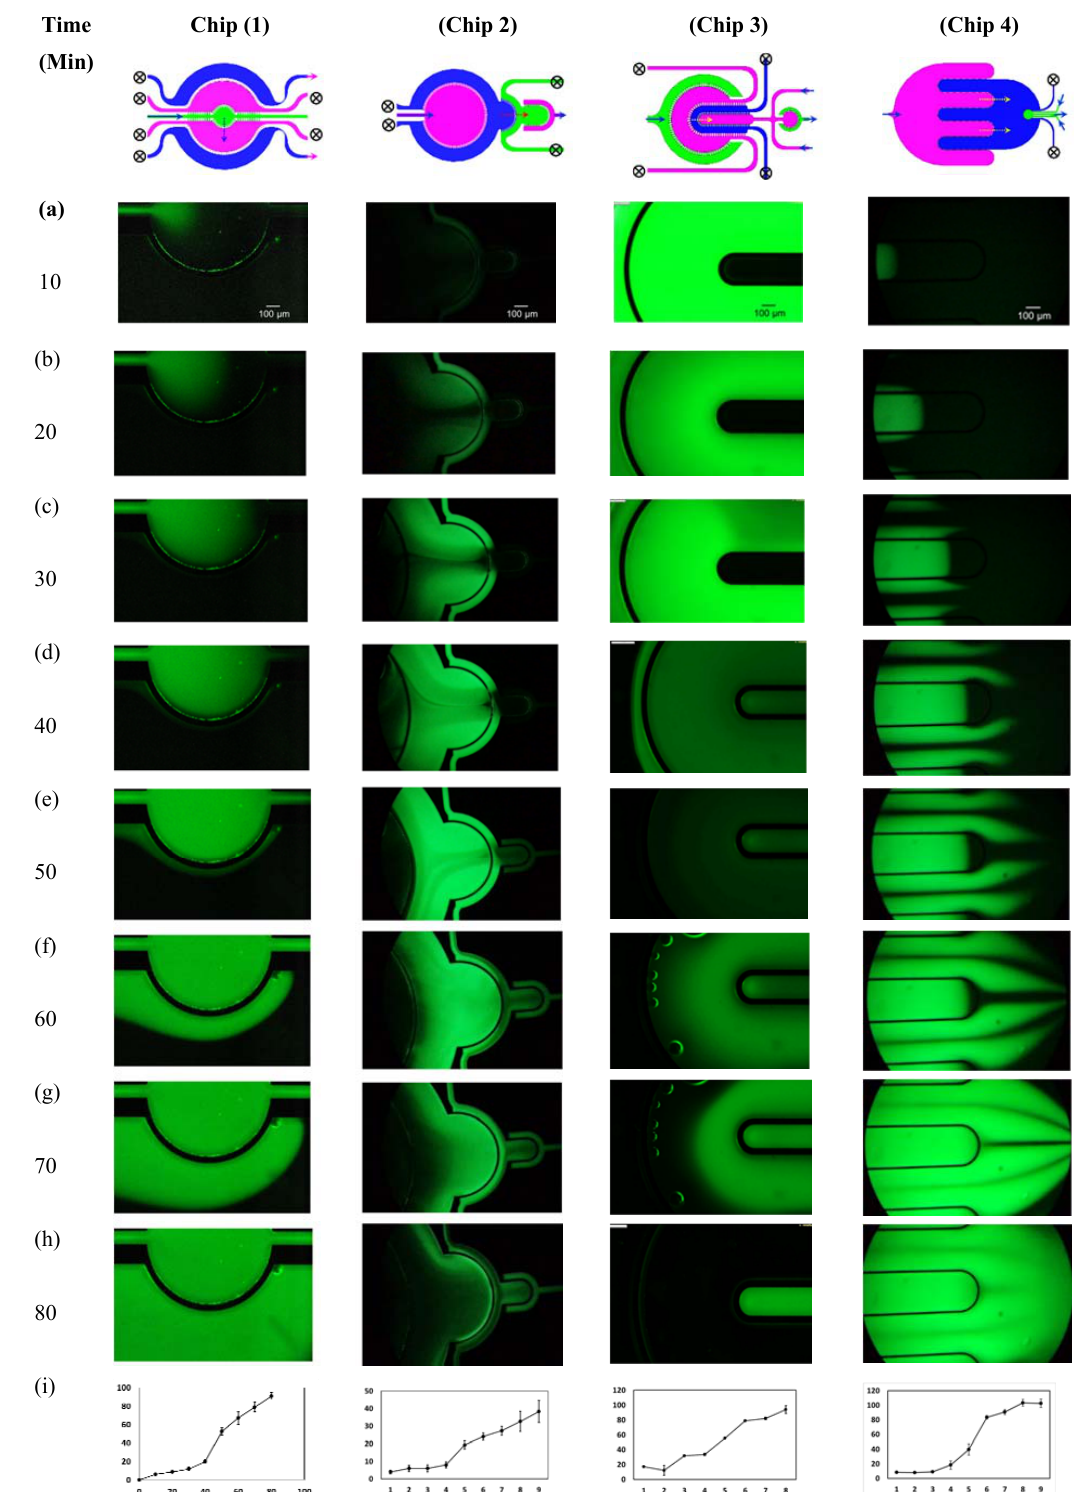
Figure 5. ( a – h ) Series of fluorescent images showing the inter-compartment transport of FITC-dextran at different time intervals over 90 min at a flow rate of 50 μ L/min. ( i ) Fluorescence intensities due to the FITC-dextran permeation from one compartment to the adjacent one, as indicated by the dotted arrows.